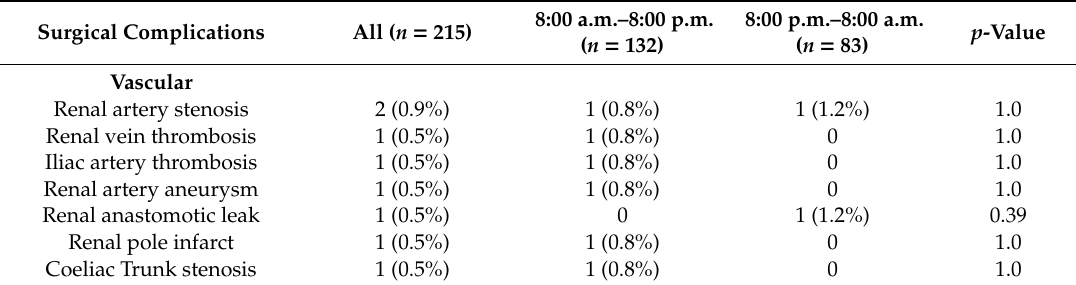
Table 4. Incidence of surgical complications. Incidence is expressed as percentages (%) of total number ( n ) of